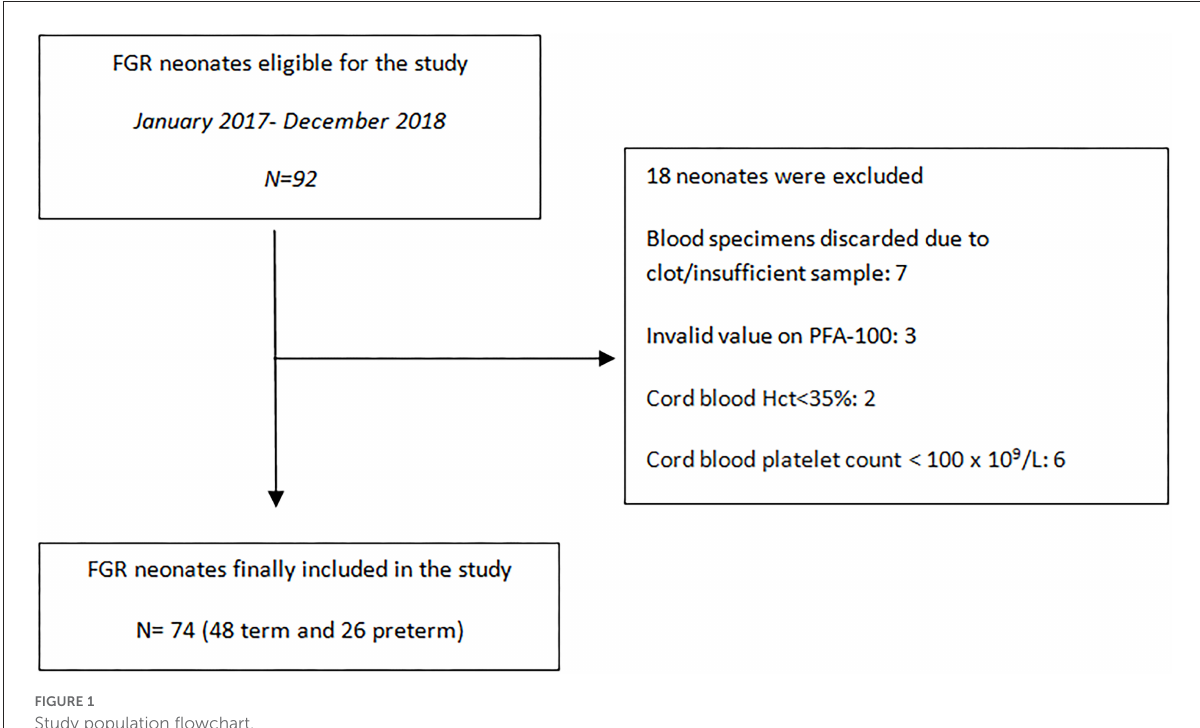
FIGURE1 Study population